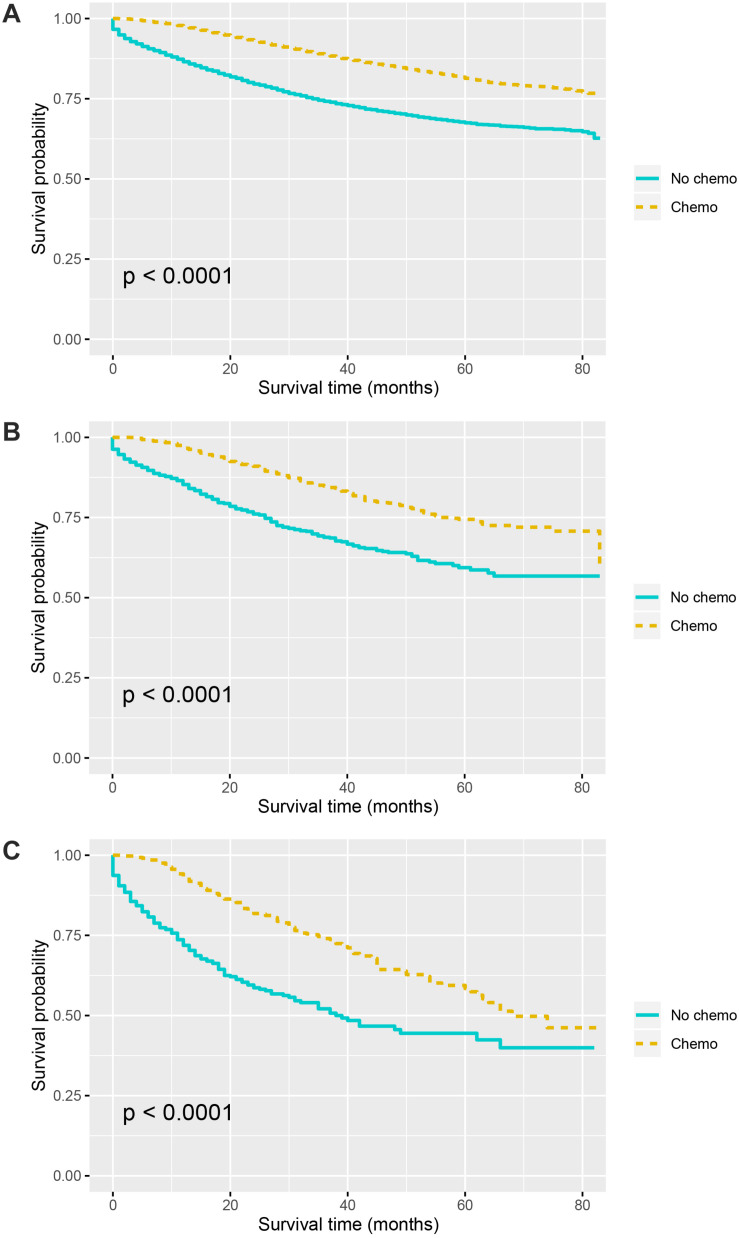
Survival curves for patients stratified by the receipt of chemotherapy or not in colon cancer patients with (A) No TDs. (B) 1–2 TDs. (C) ≥3 TDs.